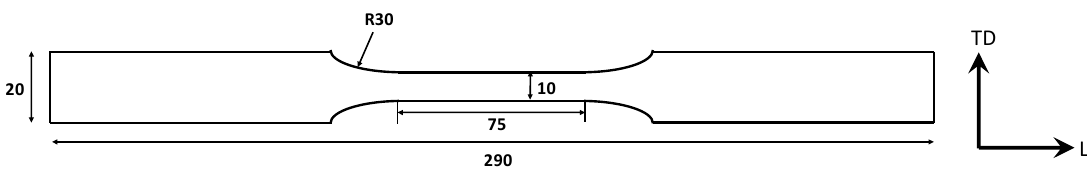
Figure 4. Tensile specimen geometry (mm) (thickness = 1.5 mm, TD = transverse direction, LD = loading direction) [61]. Adapted from [61], with permission from Elsevier, 2020.